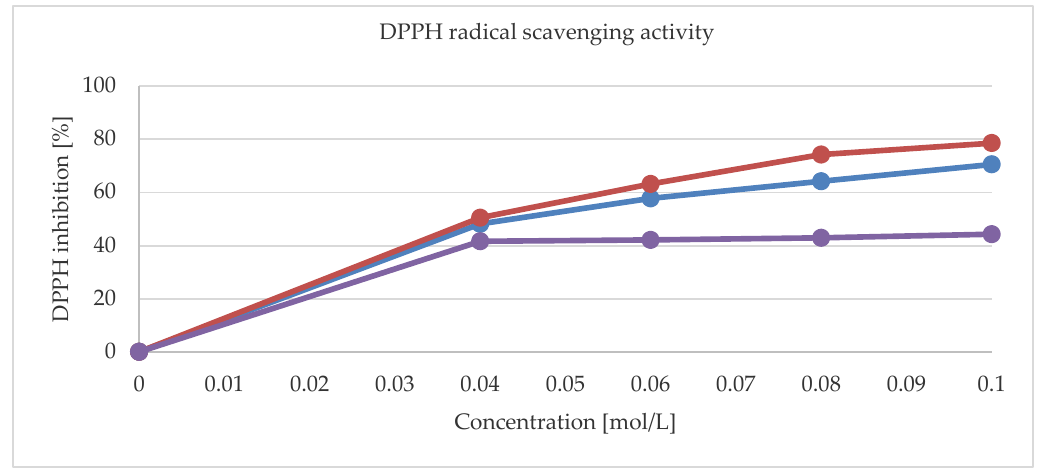
Figure 9. The (2,2- diphenyl-1-picrylhydrazyl) (DPPH) radical scavenging activity for 1 (red line), 2 (blue line), and pure thophylline (purple line).